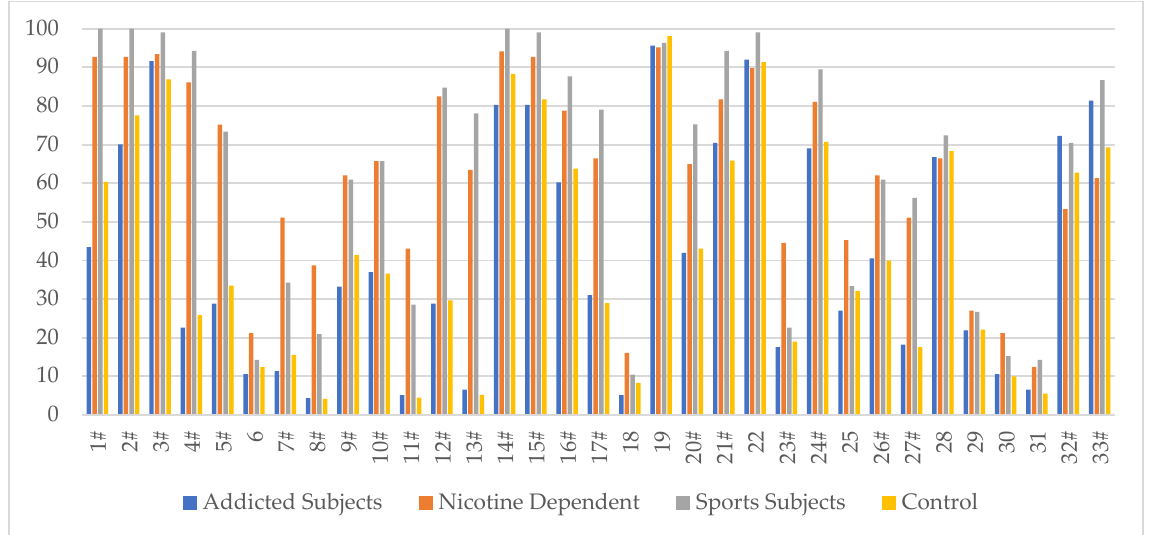
Figure 1. The methylation level (%) of 33 CpG DAT1 sites in a group of addicted subjects, nicotine- dependent subjects, sports subjects and controls. # statistically significant differences in the methyl- ation level — Bonferroni correction was applied, and p -value was lowered to 0.0015 ( p = 0.05/33 (number of statistical tests performed)). Table 2. The mean total methylation sites in a group of addicted subjects, nicotine-dependent sub- jects, sports subjects and controls.